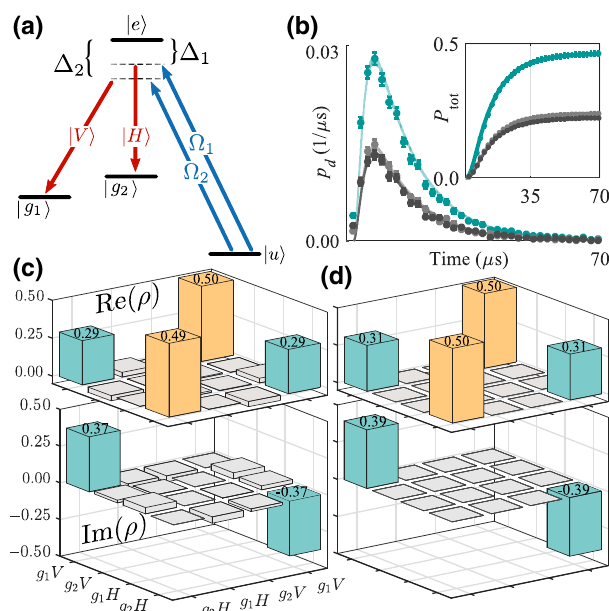
FIG. 4. Generation and characterization of the ion-photon entangled state. (a) Atomic level scheme showing the bichromatic CMRT that generates the ion-photon entangled ( | g (cid:2) | V (cid:2) + e i θ | g (cid:2) | H (cid:2) ) . The frequency dif- state | (cid:14)(θ) (cid:2) = 1 √ 1 2 2 ference of the detunings (cid:9) 1 and (cid:9) 2 is equal to the Zee- man splitting between | g 1 (cid:2) = | D J = 5 / 2 , m j = − 5 / 2 (cid:2) and | g 2 (cid:2) = = − 3 / 2 (cid:2) . (b) Wavepackets in the H / V (gray and | D J = 5 / 2 , m j black) polarization basis and their sum (green). The photon counts of all three ion-basis measurements are added up. Dots with error bars, measured data; lines, numerical simulations. Error bars represent one standard deviation, based on Poissonian photon statistics. Inset: integrated probabilities, yielding 0.224(4) for H and 0.239(4) for V . (c) Data: real (top) and imaginary (bot- tom) part of the tomographically reconstructed density matrix ρ . (d) Theory: real (top) and imaginary (bottom) part of the density matrix of | (cid:14)(θ = 0.91 ) (cid:2)